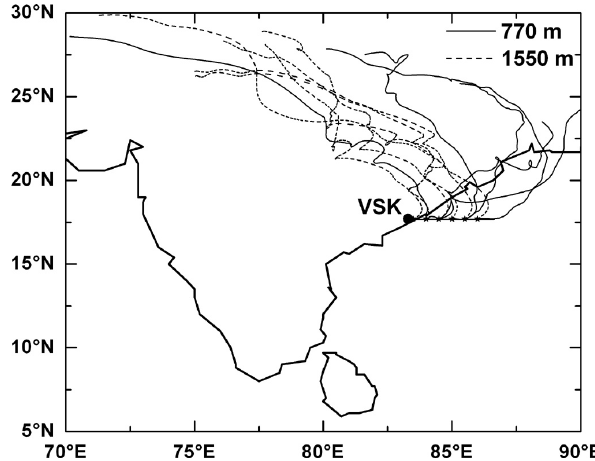
Fig. 7. Seven-day isentropic back trajectories at six locations in the flight track during BL1 at 770 (full lines) and 1550m (dashed line) altitude a.g.l. Solid round dot represents the location of the base